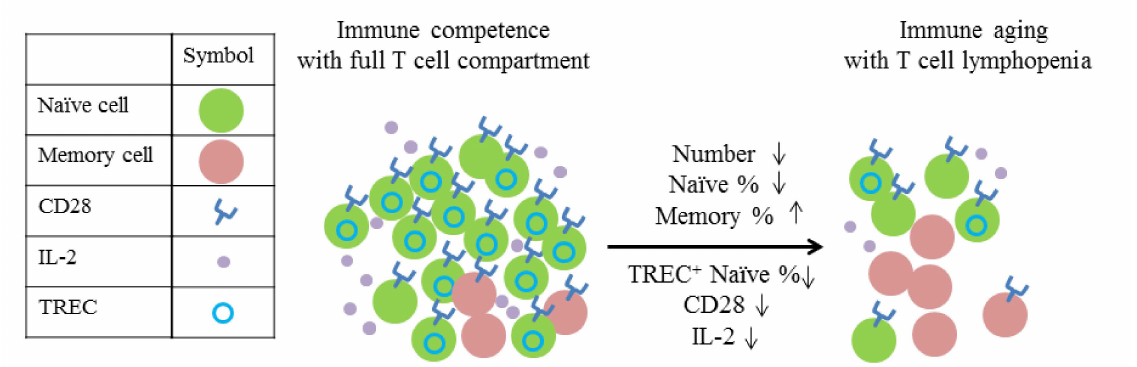
Figure 1. T cell compartment in different states.